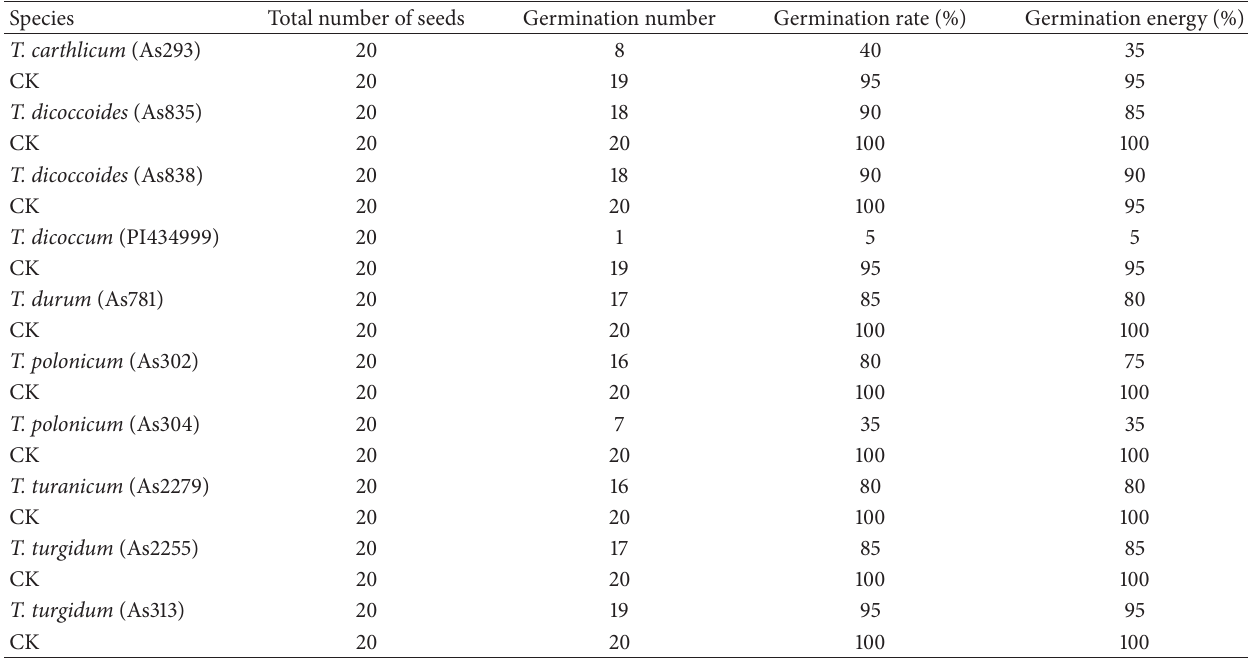
Table 2: The results of the germination.